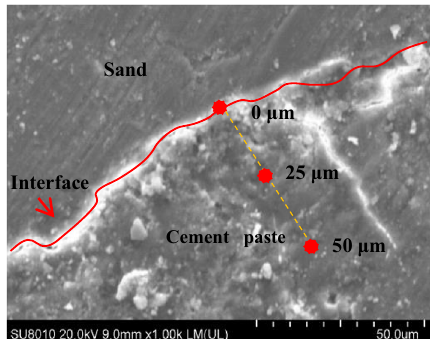
Fig. 6 Schematic diagram of the EDS